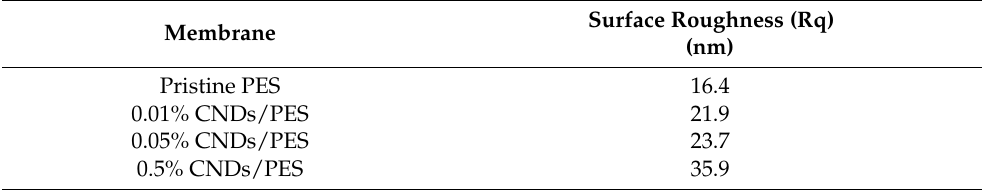
Figure 5. Characterization of the PES and CNDs/PES using atomic force microscopy (AFM). ( a ) pure PES; ( b ) 0.01% CNDs/PES; ( c ) 0.05% CNDs/PES ( d ) 0.5% CNDs/PES. Table 3. AFM statistical